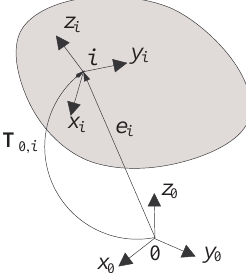
Figure 5. Homogeneous transformation matrices: illustration of the motion